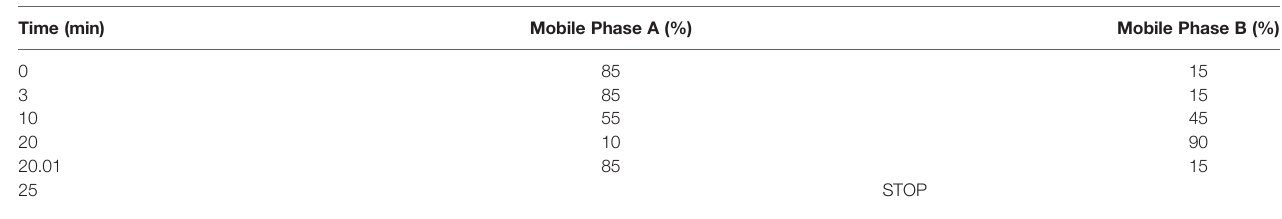
TABLE 1 | The elution gradient conditions (A: B). Time